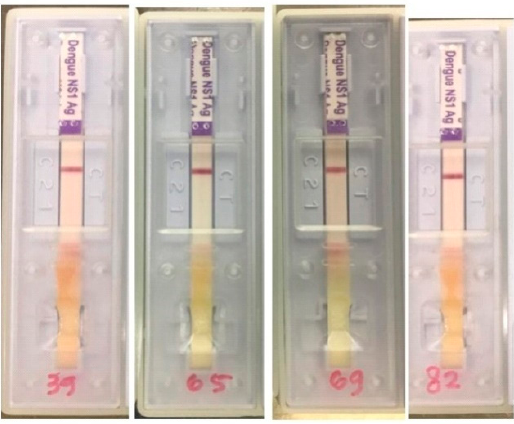
Figure 2. NS1 serological test of positive dengue antibodies samples.